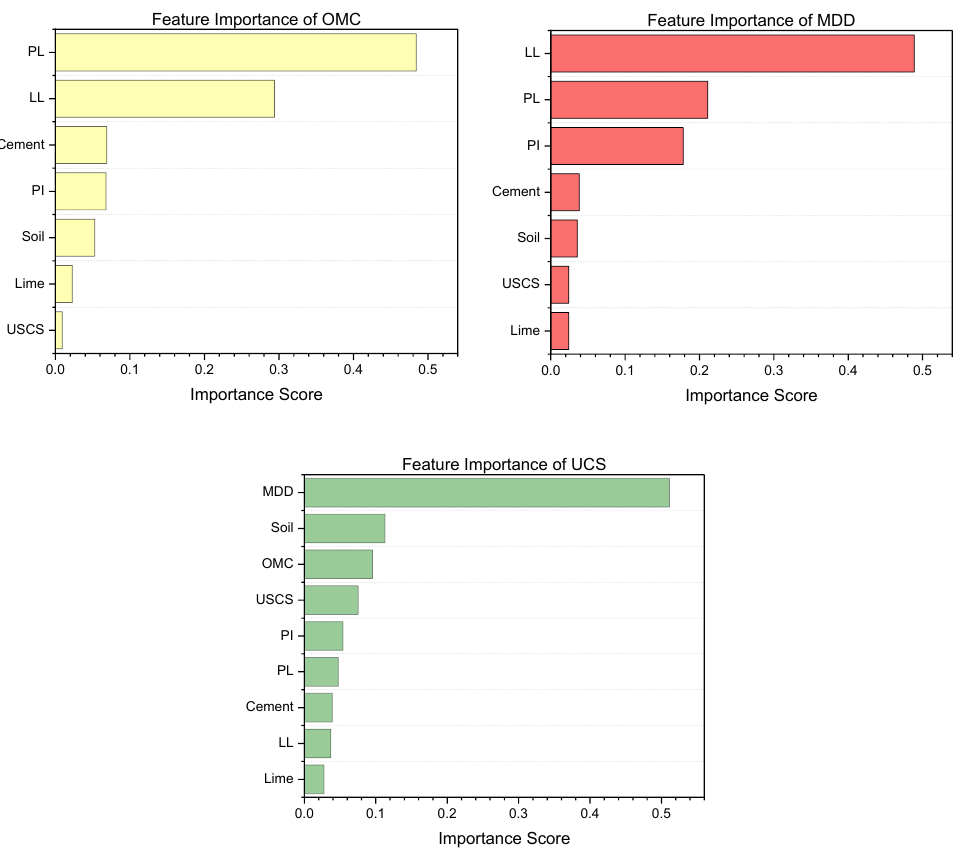
Figure 8. The feature importance score of the OMC, MDD, and UCS predictive models.